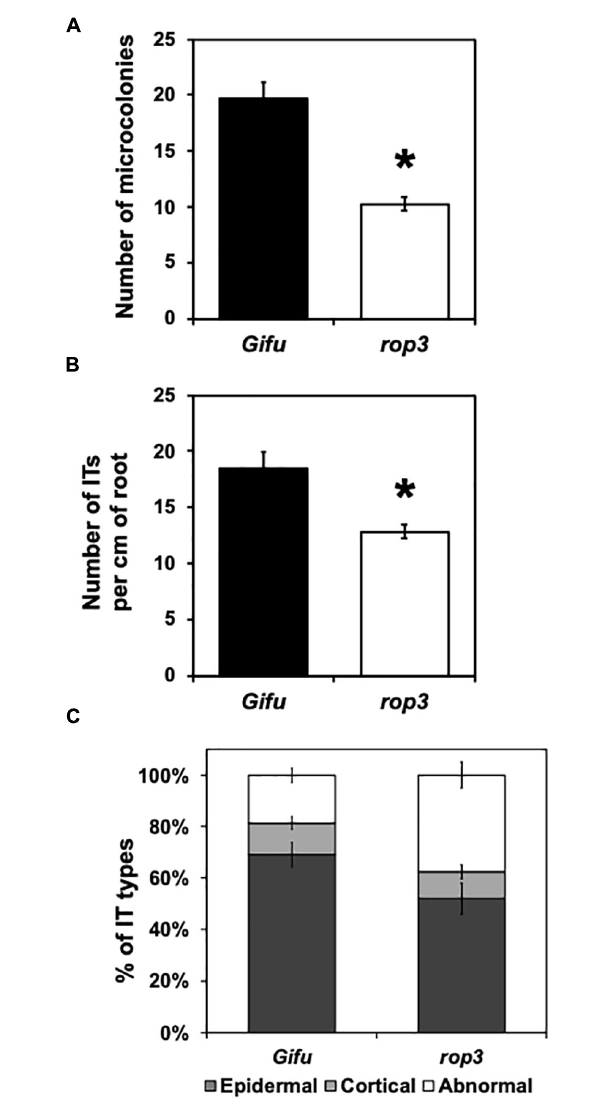
FIGURE 2 | Infection thread progression are modified in the rop3 mutant. Number of microcolonies (A) , infection thread per cm of root (B), and Infection thread types (C) were quantified on Gifu wild-type and rop3 plants at 7 DAI with M. loti . Bars represent mean values ( ± SD) of 3 independent experiments ( n > 15). The asterisk indicates statistical significance between rop3 and Gifu wild-type according to one way ANOVA test and a post hoc analysis ( p < 0.05).